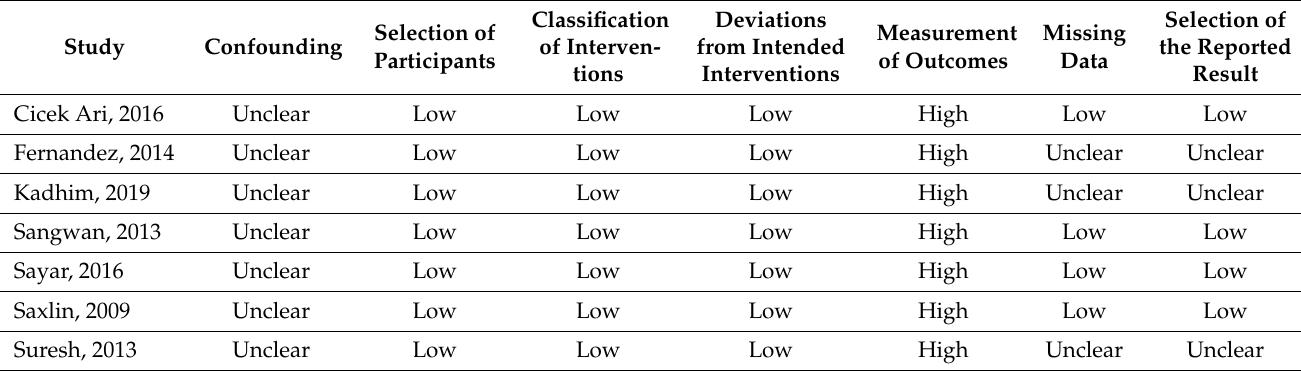
Table 3. Risk of bias of non-randomized clinical trials, assessed through the ROBINS-I tool [36], is designated as “Low”, “High” and